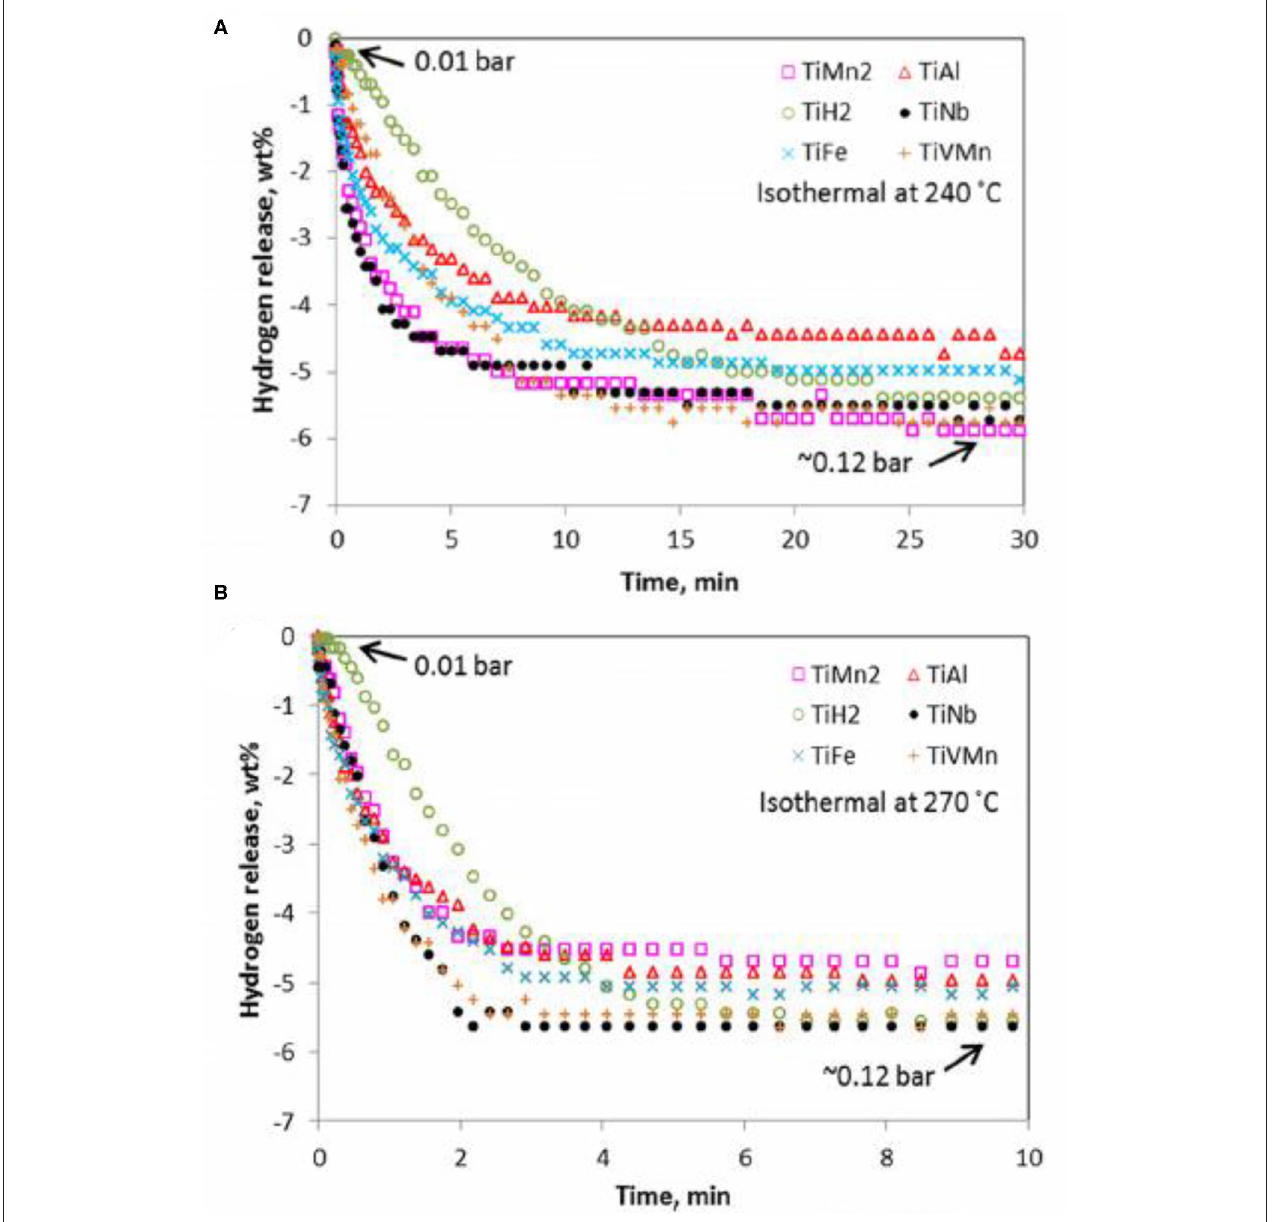
FIGURE 4 | PCT dehydrogenation kinetics for different Ti-based alloy catalyzed magnesium hydrides at 240 ◦ C (A) and 270 ◦ C (B) . Reproduced from Zhou et al. (2013) with permission from ACS Publications.